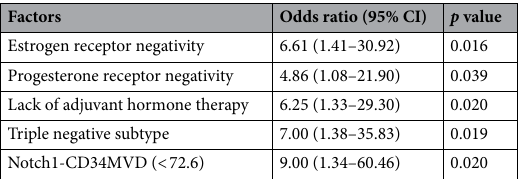
Table 4. Disease-recurrence associated clinico-pathologic factors.